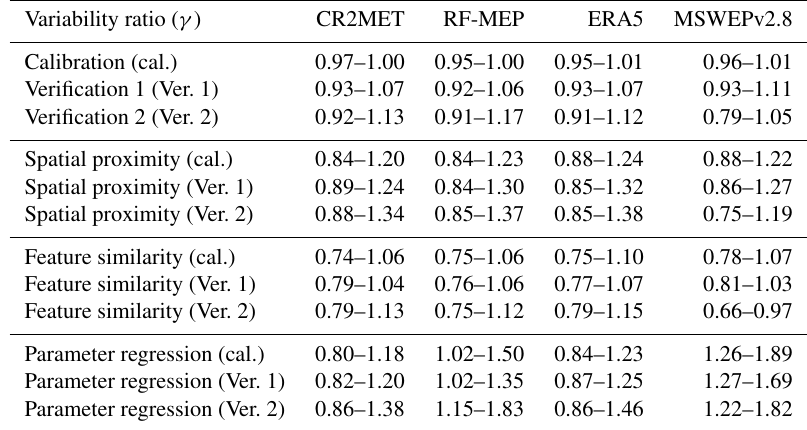
Table C3. Quantiles 0.25 and 0.75 of the variability ratio ( γ ) of the KGE (cid:48) over the selected